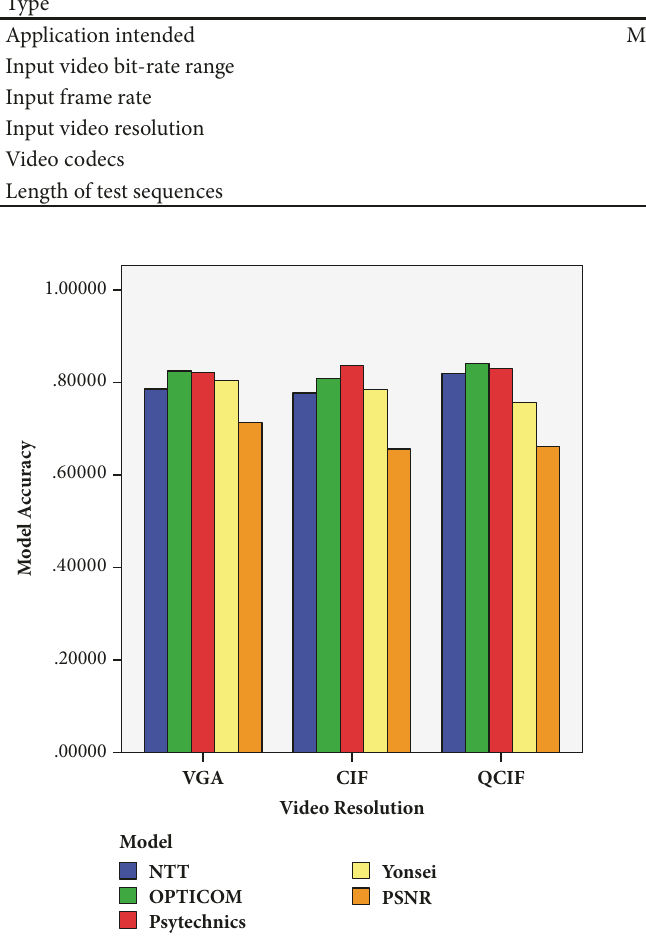
Figure 23: Comparison of model performances.